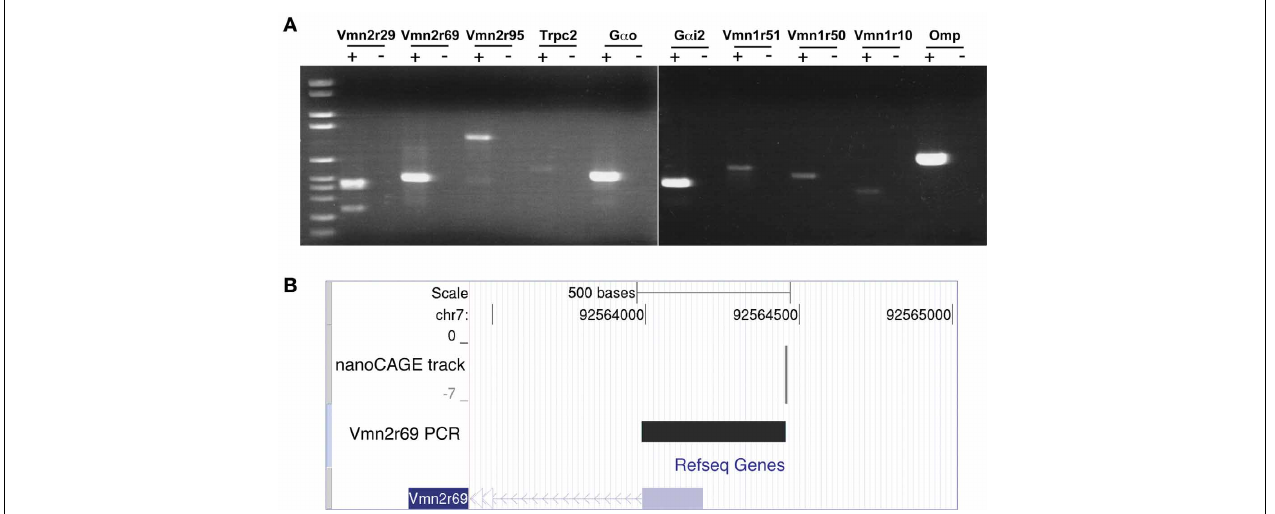
FIGURE 2 | Validation of nanoCAGE data by RT-PCR confirms the expression in the MOE of V1Rs, V2Rs, and key components of the pheromone transduction pathway. (A) RT-PCR validation was carried out starting from the same total RNA sample of the MOE used for the nanoCAGE workflow. V1Rs and V2Rs to be validated were chosen by interest or on the basis of their TPM score from the list of all expressed VRs detected